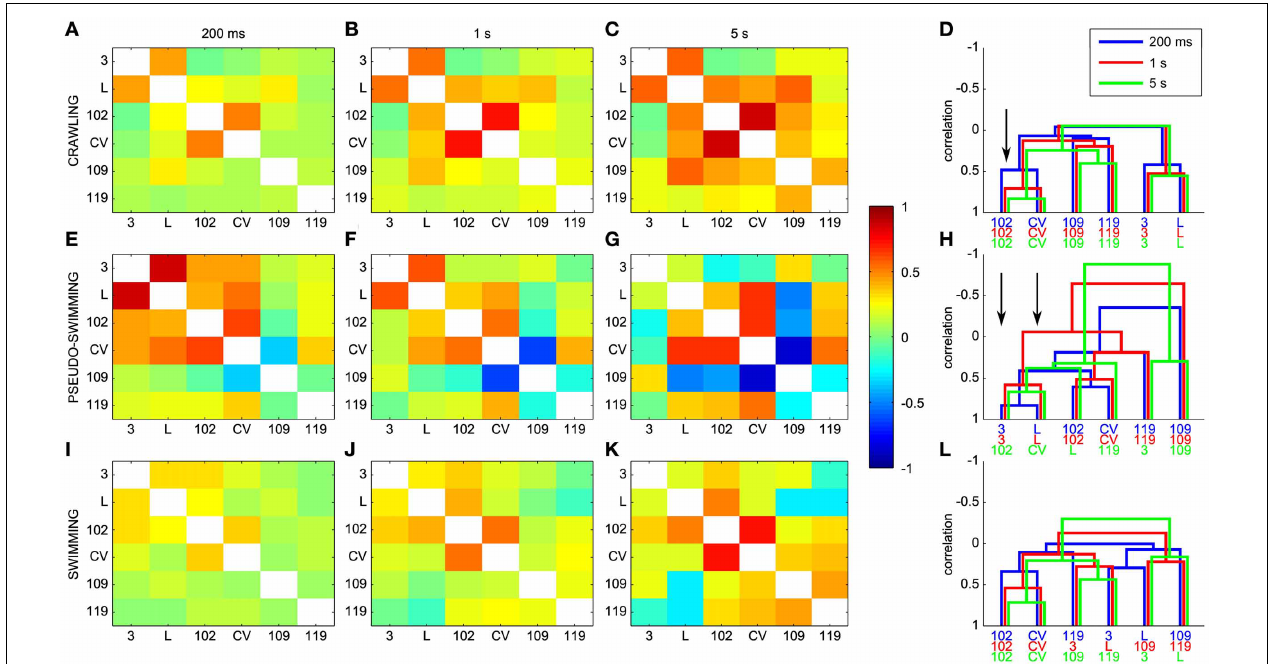
FIGURE 10 | Dendrograms and the time scale of leech behaviors. (A–C) Dependence of the cross-covariance matrices on the window (cid:3) T used for computing cross-covariances for crawling. (cid:3) T was 200ms, 1s and 5s in (A – C) , respectively. (E–G) Same as in (A–C) but for pseudo-swimming. (I–K) Same as in (A–C) , but for